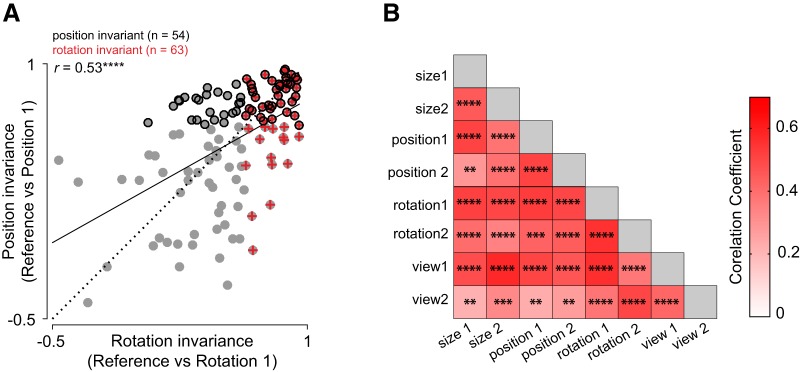
Invariances covary across neurons. A, Position invariance plotted against rotation invariance across all neurons for level 1 changes. The dashed line is the unit slope line and the solid line represents the best linear fit. Position invariant neurons are marked by black circles, rotation invariant neurons are marked by red plus symbols, and all other cells are marked using gray circles. B, Correlations between all pairs of invariances across neurons. Asterisks represent statistical significance as before.